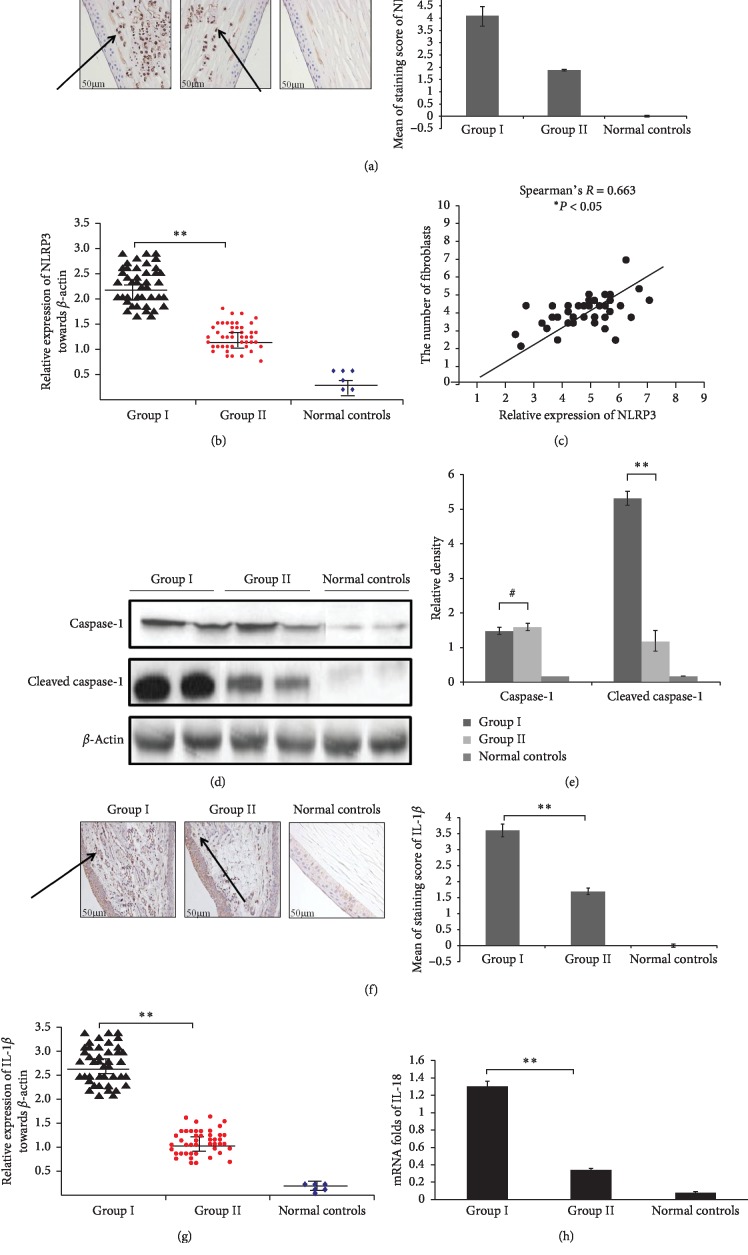
MMC suppresses the activation of NLRP3/Caspase-1 pathway in pterygium tissues. (a) NLRP3 expression in typical tissue sections from primary pterygium patients with or without MMC injection was determined by immuno-histochemistry analysis. Data were demonstrated as corresponding images (left panels) and staining score of NLRP3 with means ± SD (right panels). ∗∗P < 0.01. (b) Comparison of NLRP3 protein levels between group I and group II in primary pterygium patients was carried out by western blotting analysis. The expression levels of NLRP3 were normalized to those of β-actin, the horizontal line represents the median value, and the error bars indicate the SEM. ∗∗P < 0.01. (c) The positive relation between fibroblasts numbers and NLRP3 expression was determined by Spearman's correlation analysis. β-Actin protein was used as internal reference (Spearman's R = 0.663, ∗P < 0.05). (d, e) The protein expression of Caspase-1 and Cleaved Caspase-1 in group I and group II patients was determined by western blotting analysis. Data are shown as representatives (d) or relative densities compared with β-actin from three independent experiments with means ± SD (e) ∗∗P < 0.01 and #P > 0.01. (f) The expression of IL-1β in primary pterygium patients from group I and group II was determined by immuno-histochemistry analysis. Data are represented as representatives (left panels) or means ± SD of score staining of IL-1β (right panels). ∗∗P < 0.01. (g) Relative gray values contrasted with β-actin assessed by western blotting analysis from three independent experiments with means ± SD. ∗∗P < 0.01. (h) The mRNA expression of IL-18 in pterygium tissues from group I and group II was measured by real-time PCR analysis. Data are represented as the relative expression towards GAPDH of means ± SD in three independent experiments. ∗∗P < 0.01. Normal corneal tissues were used as controls in all of above experiments.